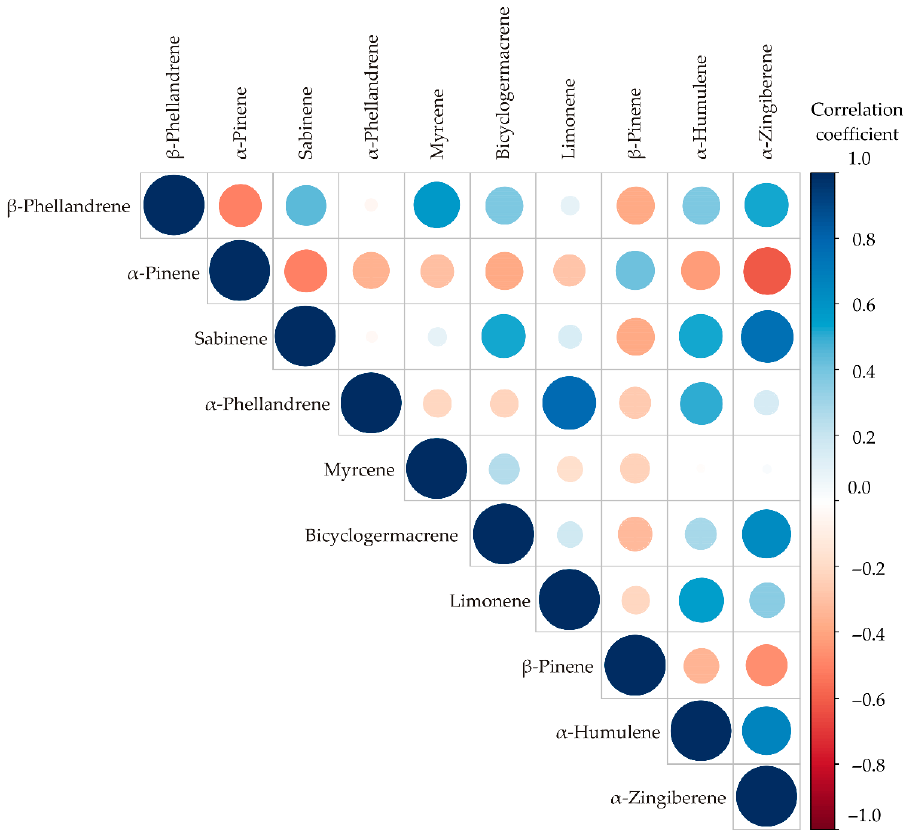
Figure 4. Correlations between different A. archangelica seed volatile compounds.